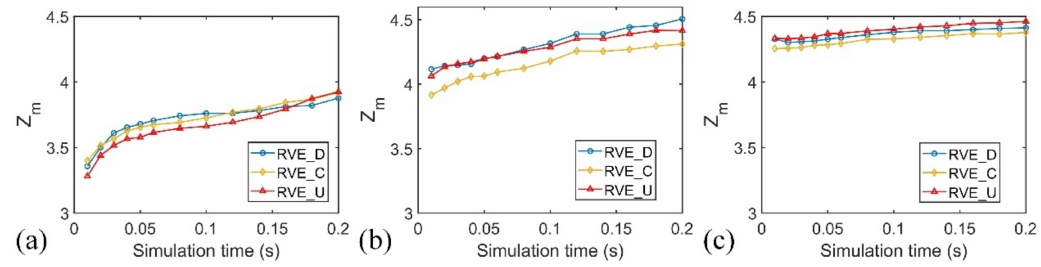
Figure 8. Evolution of Z m for specimen ( a ) FC30; ( b ) FC40; and ( c )